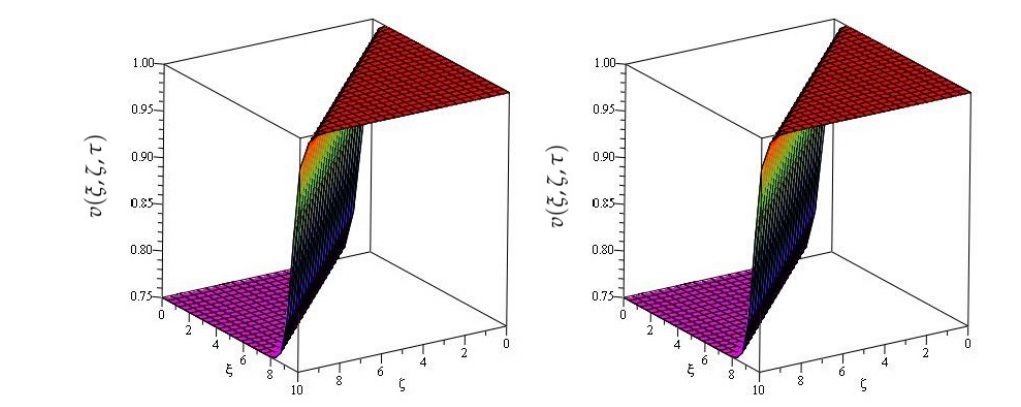
Figure 4. The exact and numerical solutions of v ( ξ , ζ , τ ) of Example 1 at β = 1.